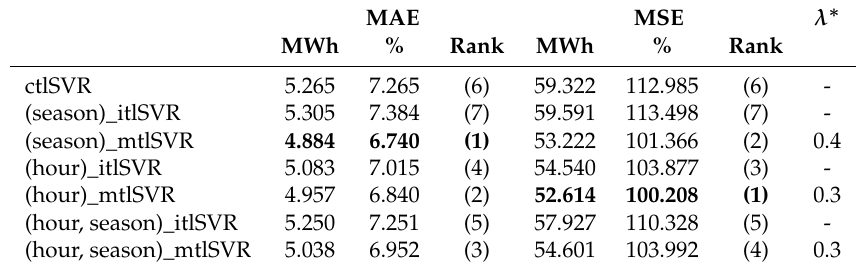
Table 2. Test MAEs (left), test MSEs (center), and optimal mixing λ ∗ (right) of the solar energy models considered in majorca. Base units are either MWh or percentages (%). The best model errors are shown in bold.